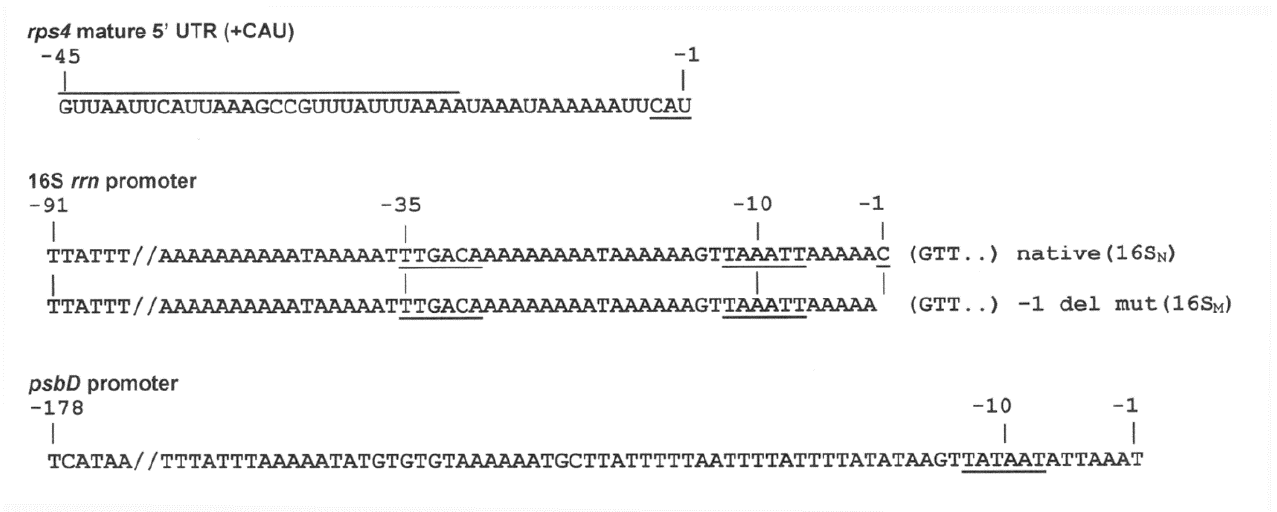
Figure 3. Nucleotide sequences of the mature rps4 5′ UTR, and the 16S rrn and psbD promoter se- quences that were used in the transgene constructs. rps4 mature 5′ UTR (+CAU) : the 5′ UTR of mature rps4 mRNA, plus the CAU sequence (underlined) added to the 3′ end during gene construction, is shown. The overlined segment corresponds to a sRNA [24]. The numbering is based on the A nt of the start codon for cry11A being +1, and so the CAU is − 3 to − 1. 16S rrn promoter: the top DNA sequence is the native 16S promoter (16S N ), and the lower is the −1 deletion mutant (16S M ). The −1 0 and −3 5 elements are underlined, and the first 3 nt of the rps4 5′ UTR sequence (GTT..), which would be numbered +1 – +3 for the native 16S construction are in parentheses. psbD promoter: the psbD pro- moter DNA sequence was, like the 16S promoter sequences, fused directly to the mature rps4 5′ UTR sequence. The −1 0 element is underlined.